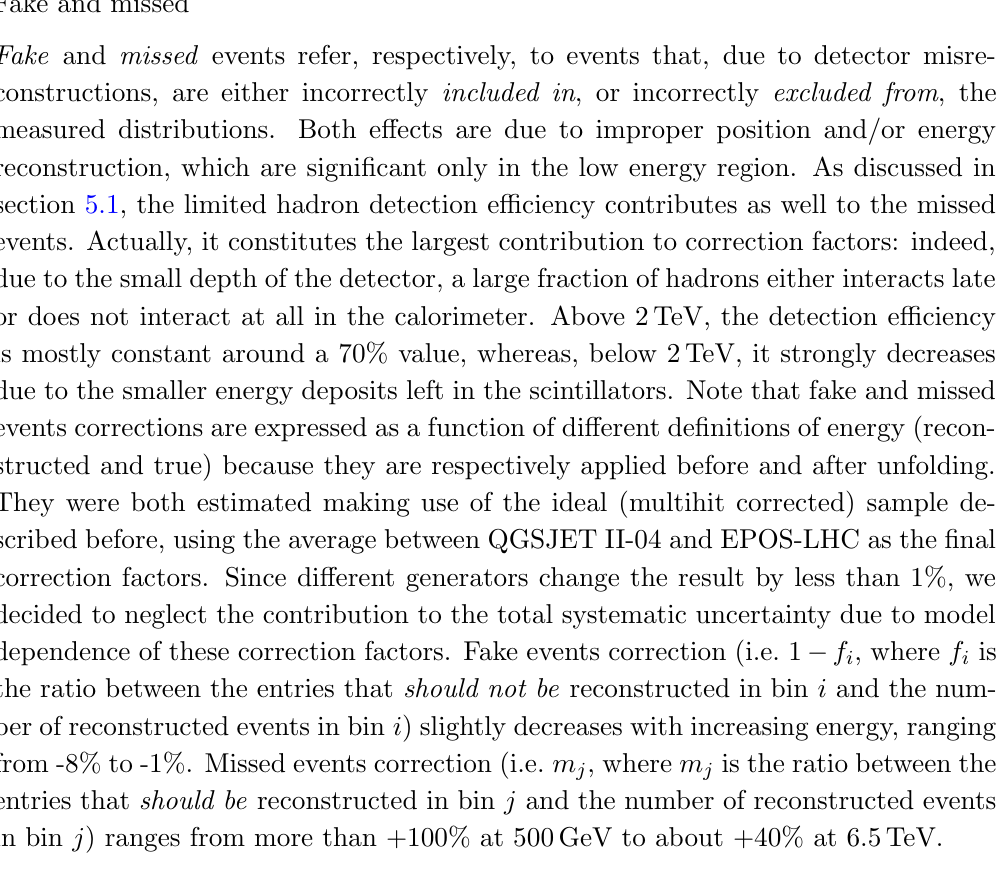
Figure 3 . Template (cid:12)t for the reconstructed energy bin 4000 GeV < E < 4250 GeV of pseudo- rapidity region A. The binning of the L 2 D scale varies depending on the expected statistics for each energy bin. QGSJET II-04 hadrons (blue) and photons (red) distributions were (cid:12)tted to experimental data (black). The result of the (cid:12)t is shown in green. (cid:15) Fake and